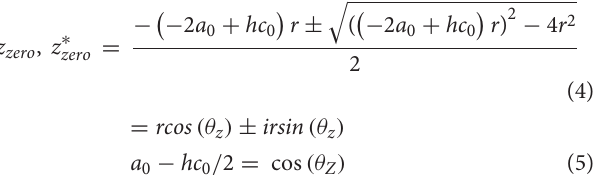
where θ R is the pole angle in the z plane. The conjugate